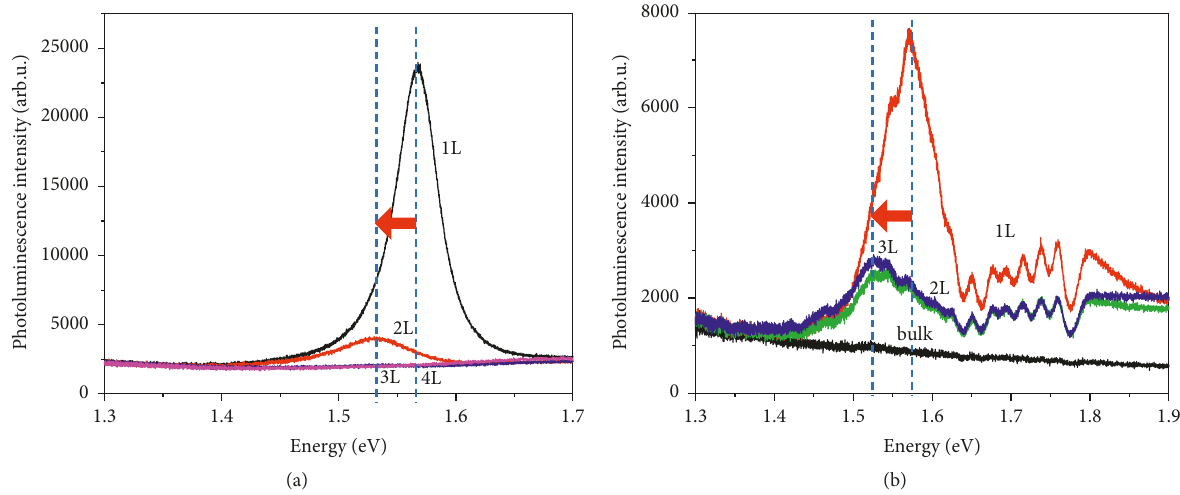
Figure 4: (a) Photoluminescence (PL) of 1L–4L MoSe 2 . 1L MoSe 2 has highest PL intensity—stronger PL intensity indicates that bandgap transformsfromindirect todirect.Bandgapincreaseswiththedecreaseinthickness.(b)PLof1L–3LandbulkWSe 2 ,withthesametrendasMoSe 2